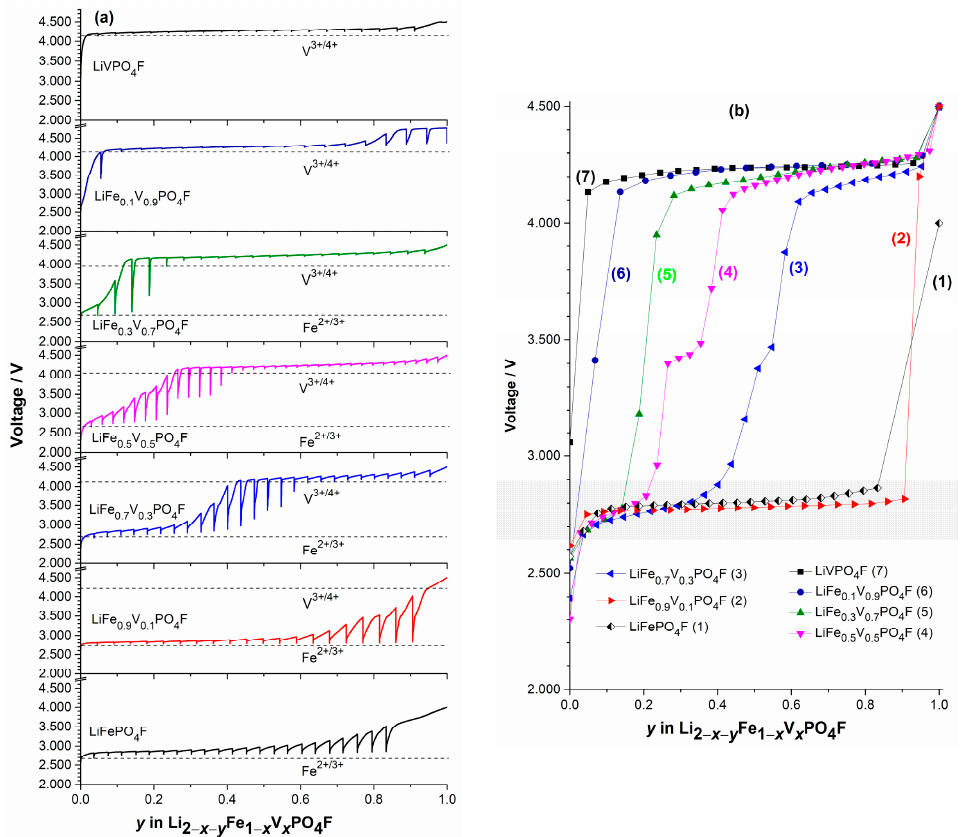
Figure 8. The independent ( a ) and overlaid ( b ) curves of voltage as a function of Li + -extraction content y under load and rest by galvanostatic intermittent titration technique (GITT) measurements in II Fe Li (cid:2870)(cid:2879)(cid:3051)(cid:2879)(cid:3052) (cid:2869)(cid:2879)(cid:3051)